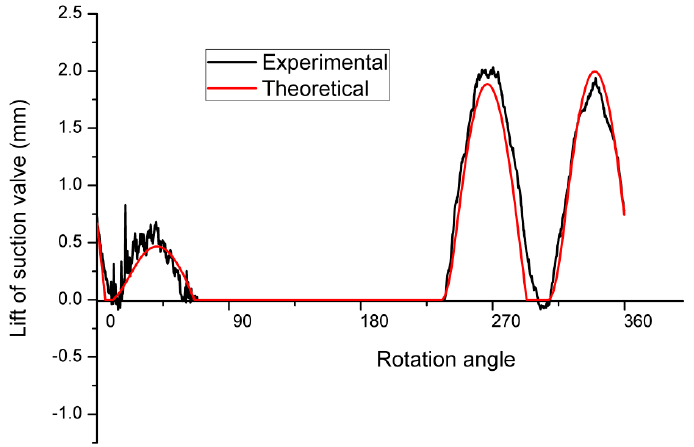
Figure 12. Comparison of the experimental and calculated lift of suction valve.